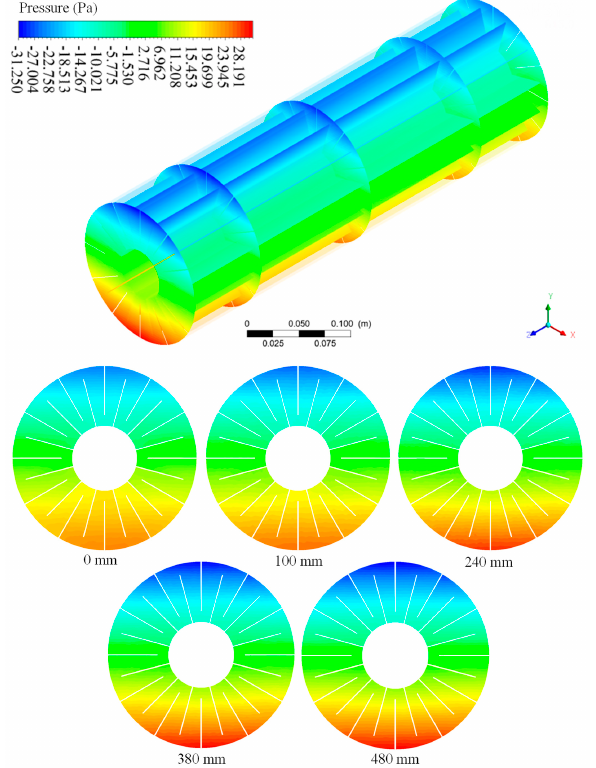
Figure 20. Pressure distribution in the PCM domain for 20% (t = 8862 s) of its volume in a liquid state.